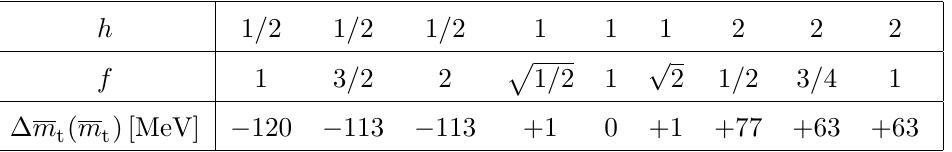
( m ) when (cid:12)tting t t